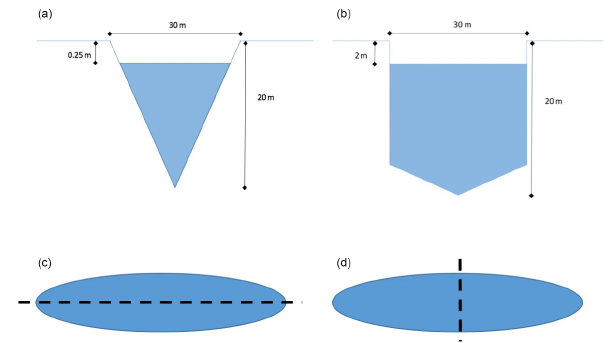
Figure 8. The crevasse geometries modelled (a, b) and possible alignments with an oblong lake (c, d) . The two idealized crevasses, 90% filled with meltwater, are a purely triangular crevasse (a) and a rectangular crevasse with a triangular tip (b) . The modelled crevasse alignments with the lake are shown using a dashed line to represent the crevasse (c, d)